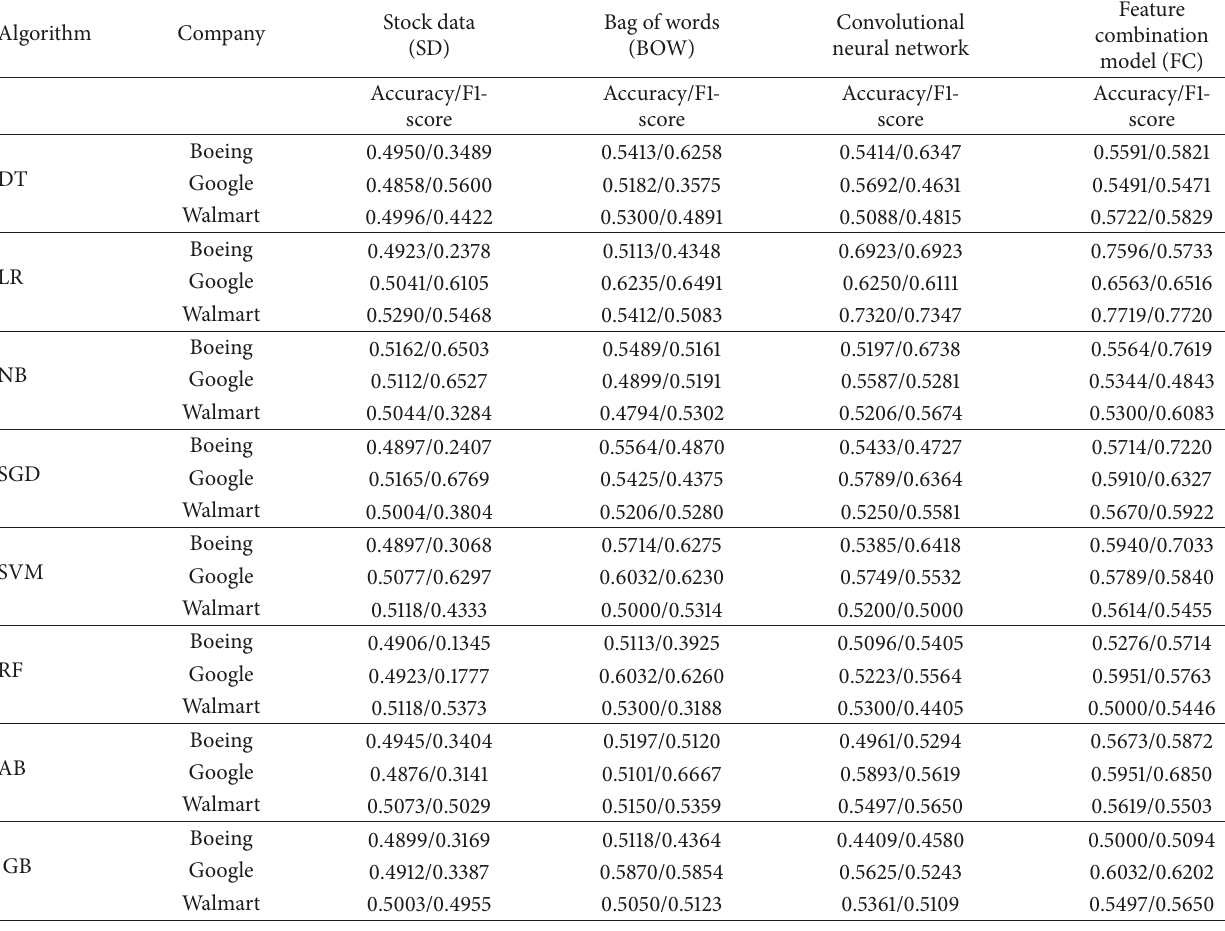
Table 10: Results for data extracted from CNN.